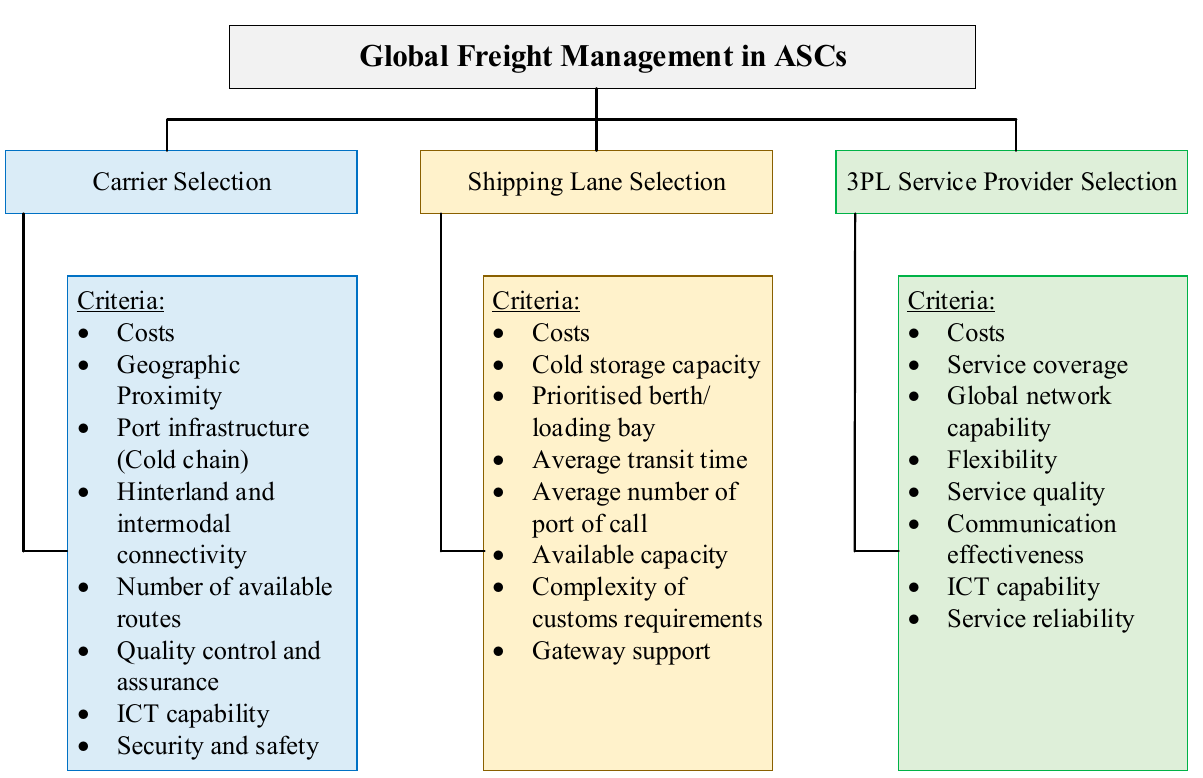
Figure 3. Decision criteria of the global freight management in agricultural supply chains.